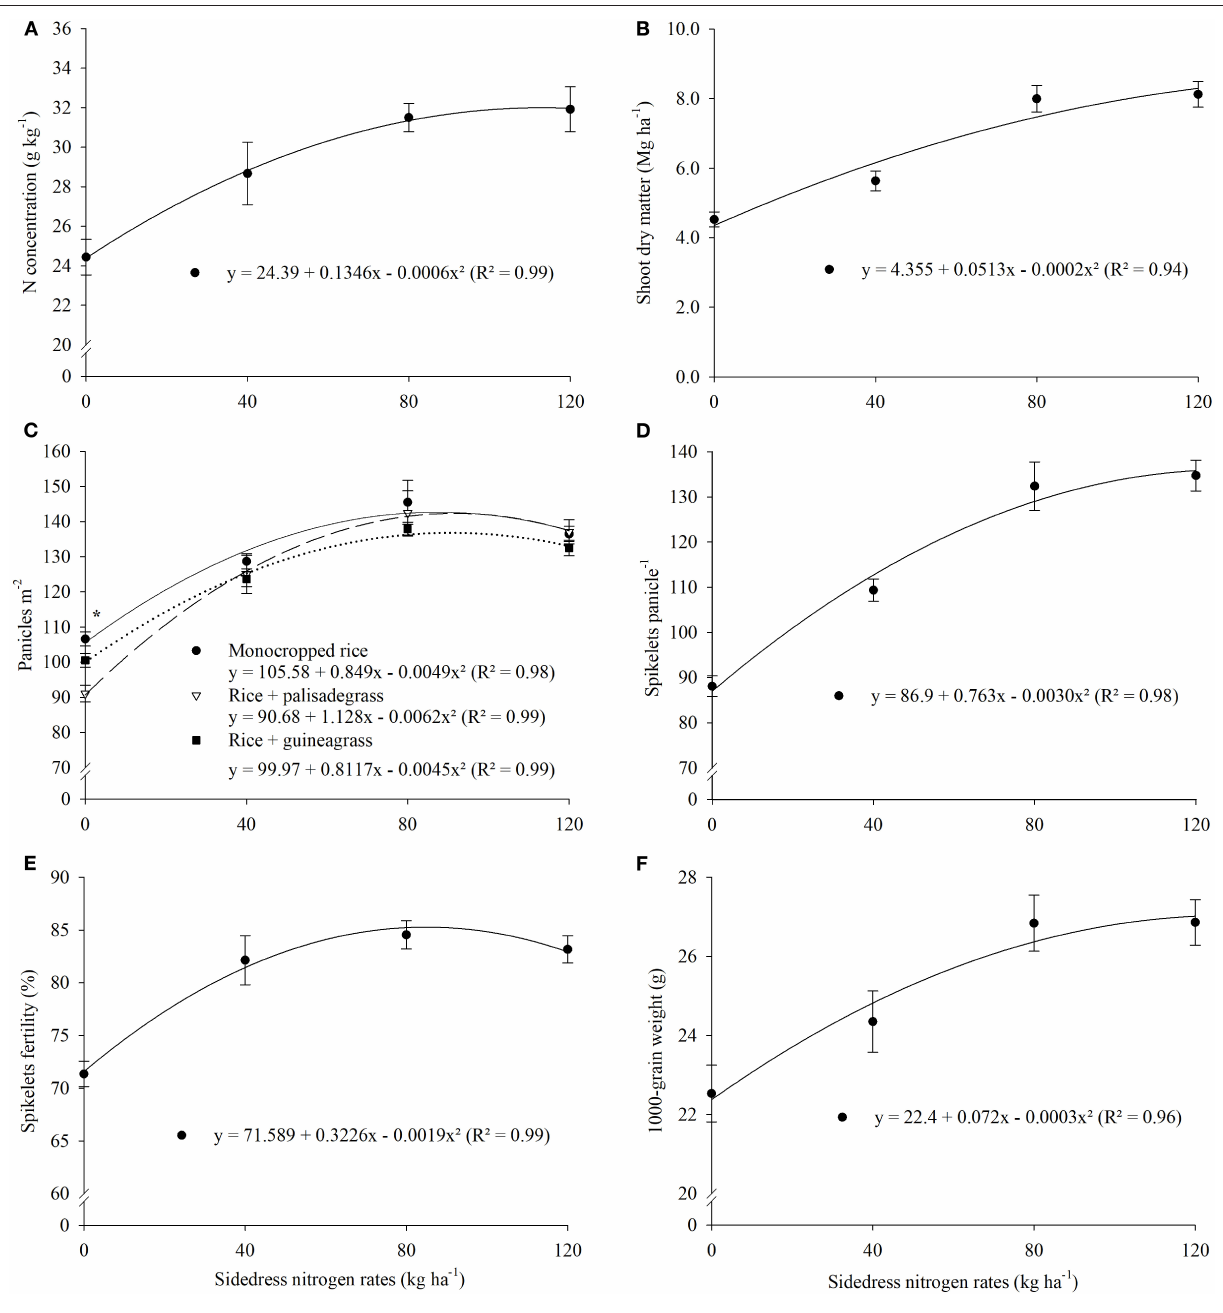
ha − 1 ( Figure 1B ), spikelets per panicle (135) at 127 kg N ha − 1 ( Figure 1D ), spikelet fertility (85%) at 85 kg N ha − 1 ( Figure 1E ), 1,000-grain weight (22.8 g) at 120 kg N ha − 1 ( Figure 1F ), and NUE (32 kg kg − 1 ) at 68 kg N ha − 1 ( Figure 2B ). The effects